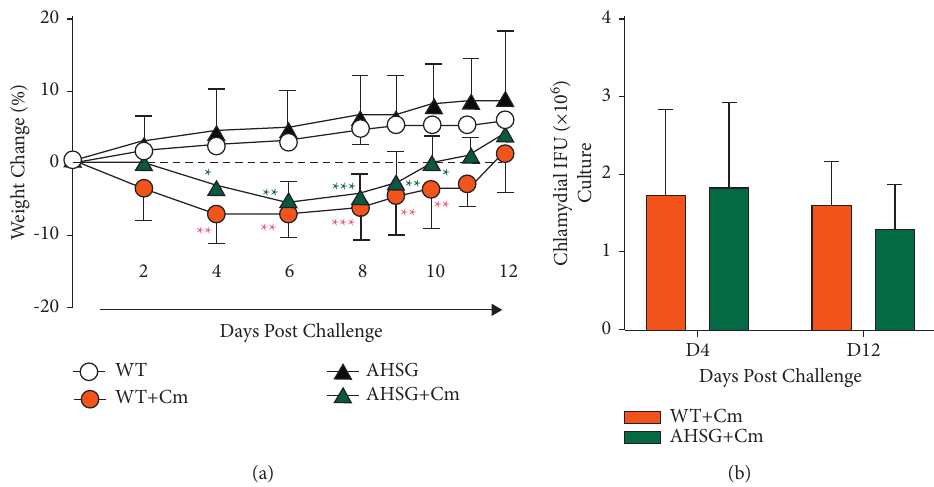
Figure 1: AHSG mice are susceptible to chlamydial infection. (a) Weight change as a function of days post Cm challenge. Age-matched wild-type (WT) C57BL/6 and fetuin-A-deficient AHSG mice ( n � 6 per group) were challenged intranasally with 500IFU Cm and monitored for weight change for 12 days. Mock (sucrose-phosphate-glutamate buffer) challenged mice were used as control. (b) Bacterial burden. At indicated days, the number of viable Cm in the lungs ( n � 4 per group) was determined by infecting McCoy cell cultures with lung tissue homogenate for visualization of inclusions by fluorescence microscopy (cf., Materials and Methods). Weight change and Chlamydia IFU data represent the mean ± SD. Differences in weight change between the same strain of Cm-infected and mock-treated mice were analysed by 2-way ANOVA with Tukey’s multiple comparison test. ∗ P < 0 . 05, ∗∗ P < 0 . 01, ∗∗∗ P < 0 .